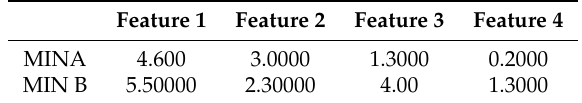
Table 8. The minimum values extracted from the first five features.